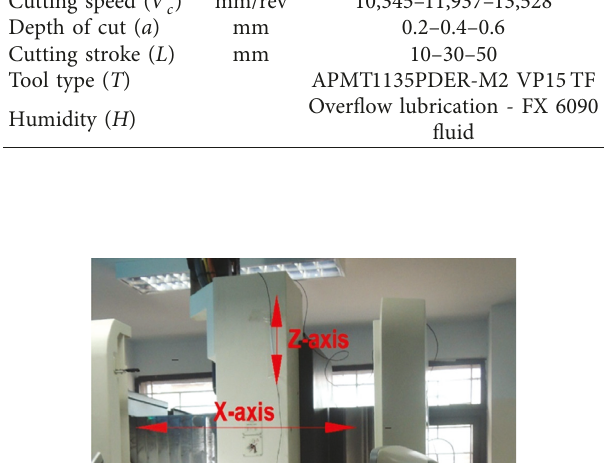
Table 2: Process parameters for milling 6061 aluminum alloy. Cutting factor Unit Table feed rate ( V f ) mm/min